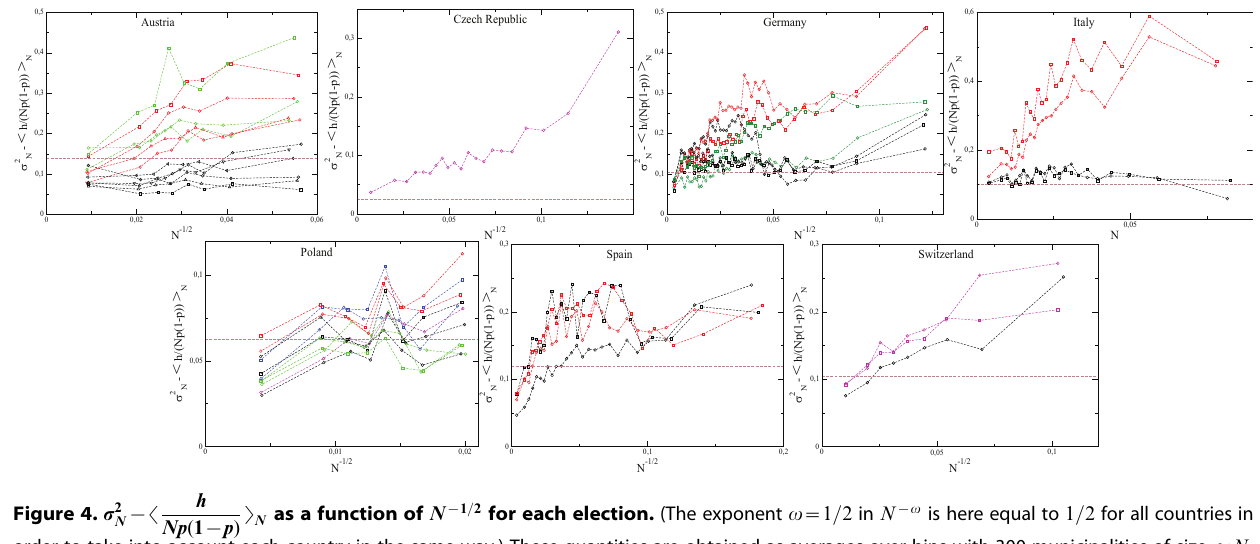
h { S T N as a function of N { 1 = 2 for each election. (The exponent v ~ 1 = 2 in N { v is here equal to 1 = 2 for all countries in Figure 4. s 2 N Np ( 1 { p ) order to take into account each country in the same way.) These quantities are obtained as averages over bins with 300 municipalities of size & N . The dashed line corresponds to b 2 s 2 as extracted from the spatial correlations of t (cf. Fig. 9). For election labels, see Figs. 1, 2. See Fig. S2 w in Appendix S1 for Canada, Mexico and Romania.